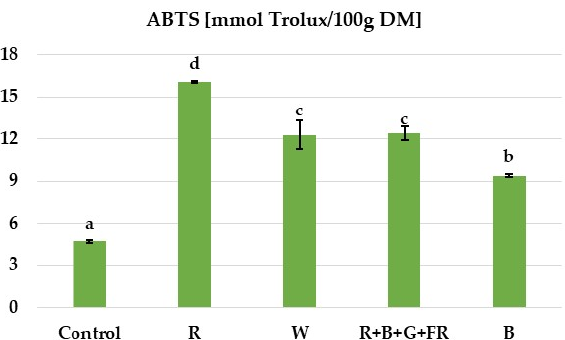
Figure 7. Antioxidant activity of rhubarb ‘Raspberry’ plantlets after 10 weeks of growth in GM1 and under different LED light treatments (control—natural light, R—red, W—white, B—blue, R+B+G+FR—far red). Bars represent means ± SE. Values marked with the same letter within each sugar type do not differ significantly according to the Duncan’s test ( p = 0.05). Table 5. Pearson’s linear correlation matrix between growth parameters (petiole mass, petiole length, leaf area), total soluble sugars, total anthocyanins, and total phenolic content, and antioxidant activity of rhubarb petiole extracts. The differences in correlation are shown in distinct colours. Dark magenta indicates a high correlation, and light magenta shows a low correlation.